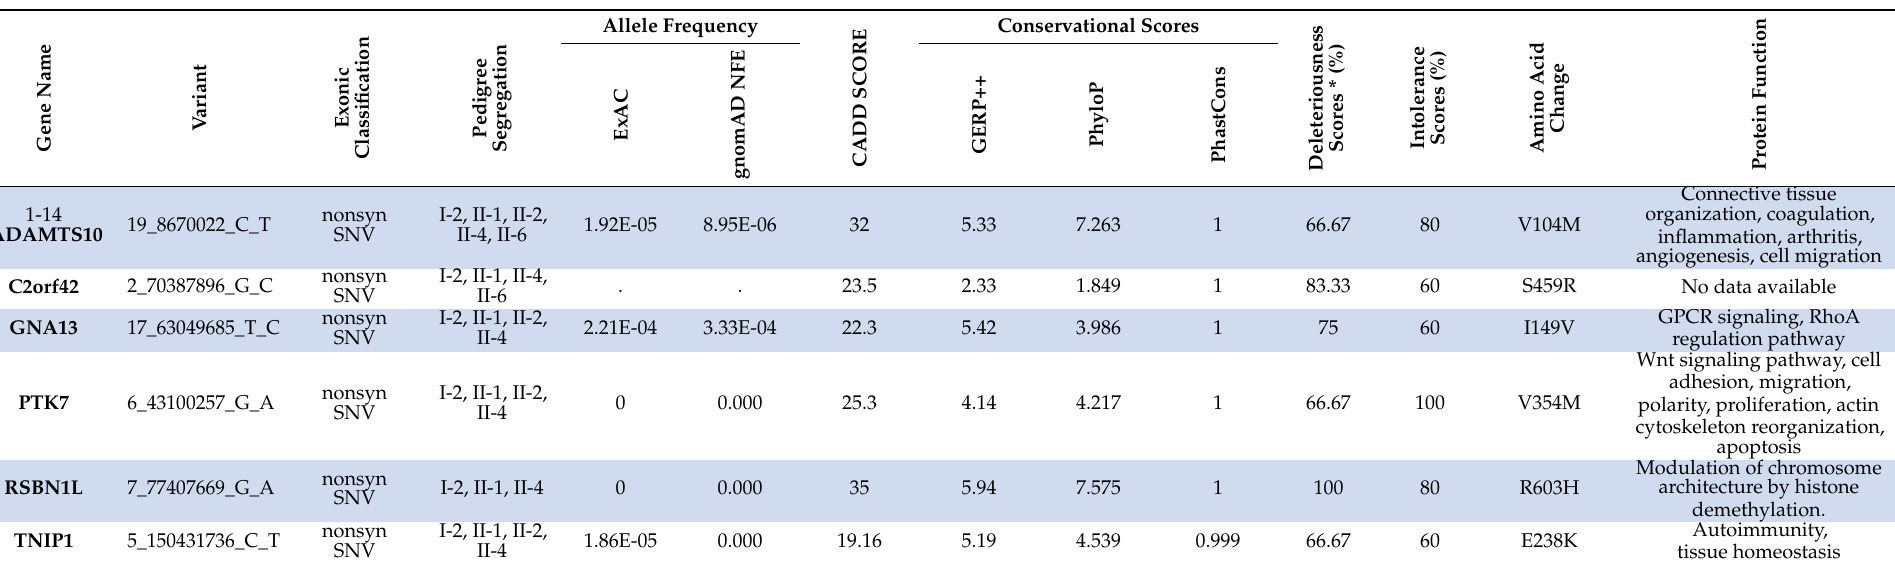
Table 1. Exonic variants prioritized in the analyzed CRC family. Chromosomal positions, classifications, pedigree segregation, allele frequencies, PHRED-like CADD scores, conservational scores, and the percentage of positive intolerance and deleteriousness scores are summarized for each variant. Respective protein functions derived from Genecards are included [19].